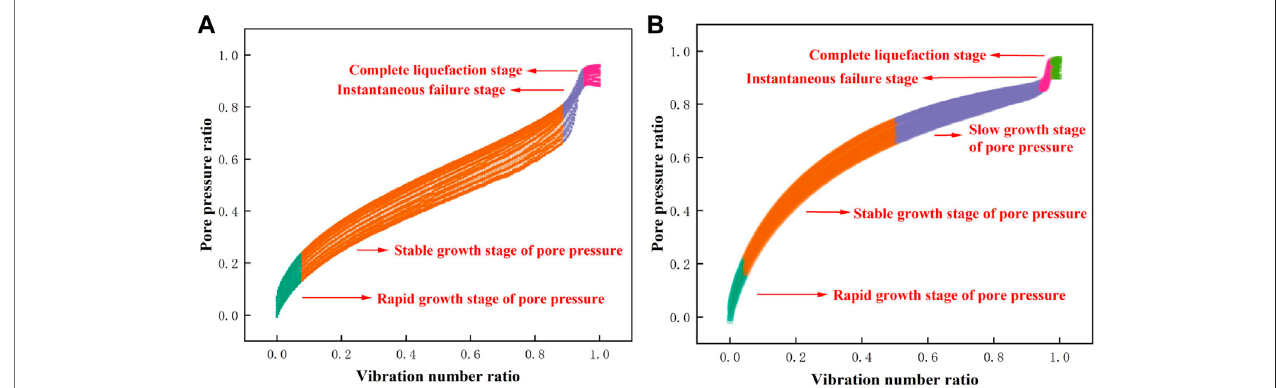
FIGURE 5 | Development curves of instantaneous pore pressure of typical PG: (A) unidirectional vibrations; (B) bidirectional vibrations.